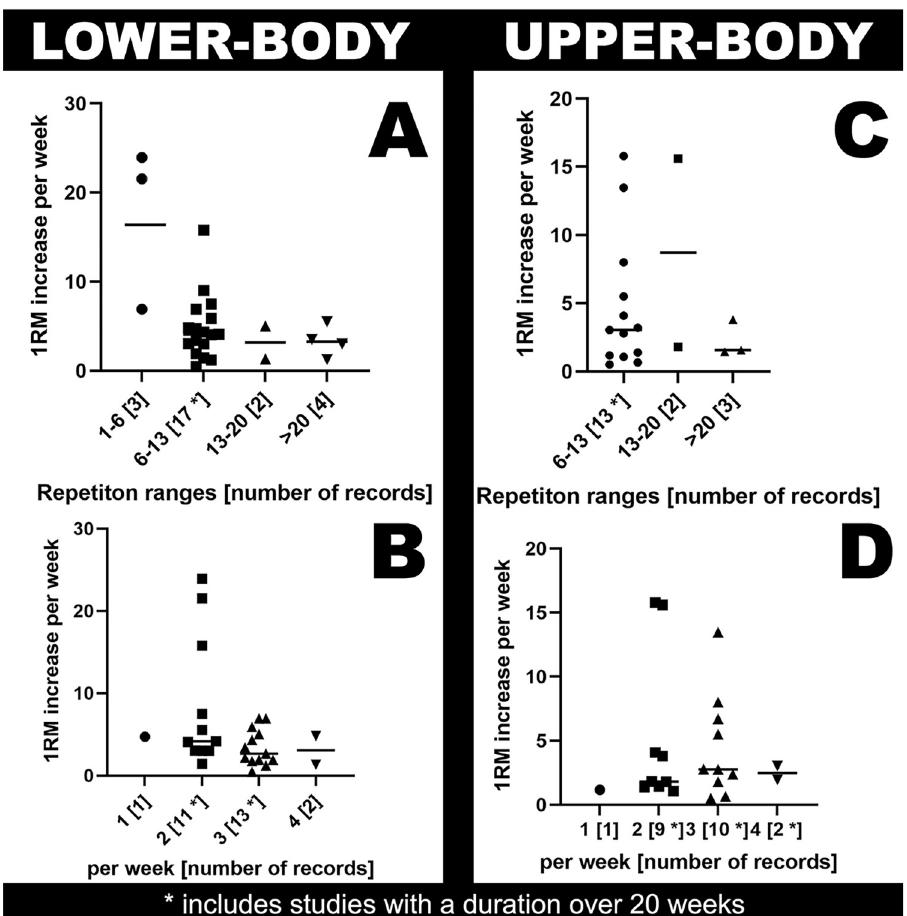
Fig 4. Evaluation for repetitions per set and training frequency per week for all included studies. ( A) Lower-body repetitions per set, (B) lower-body training frequency per week, (C) upper-body repetitions per set and (D) upper- body training frequency per